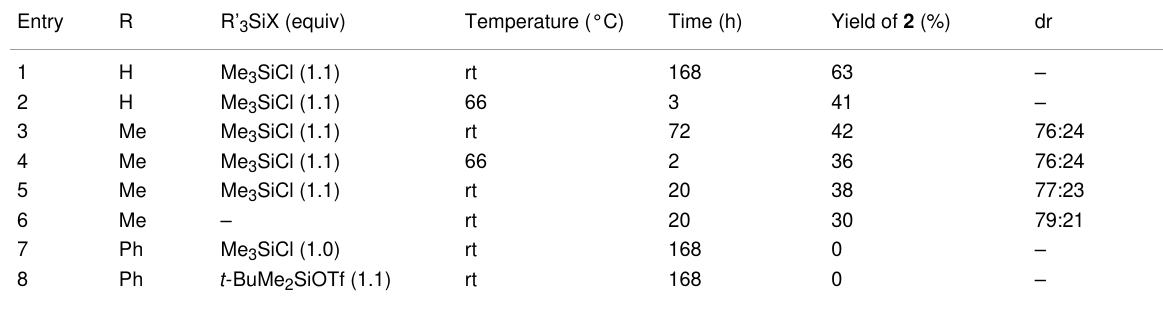
Table 1: Ireland–Claisen rearrangement of 1a – c with LDA as the base without organocatalysts. Entry